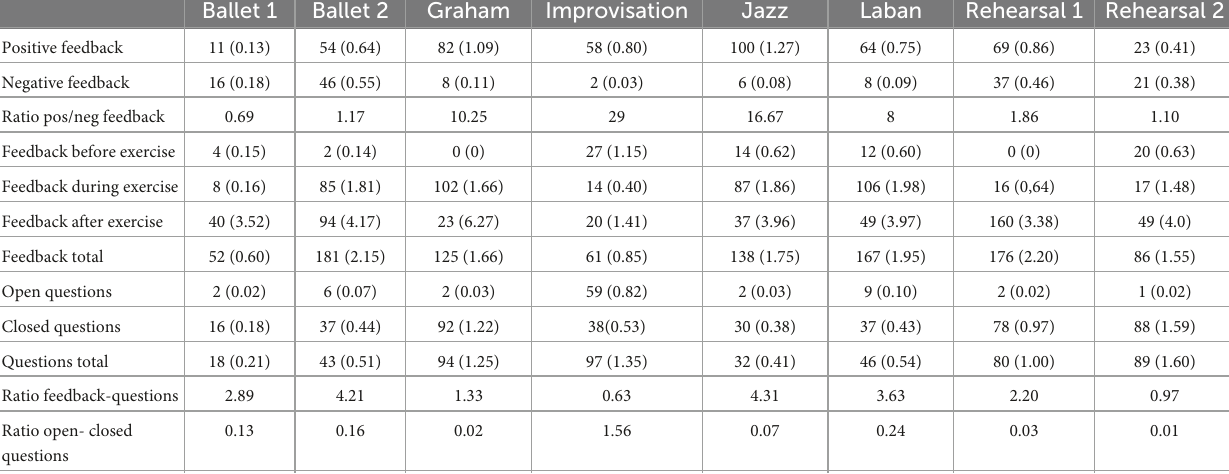
TABLE 3 Absolute numbers (TPM between brackets) for direct feedback comments and questions per class/rehearsal.